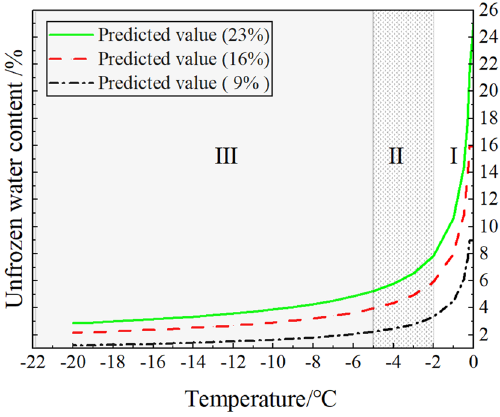
Figure 8. Changes in unfrozen moisture content in silty clay.